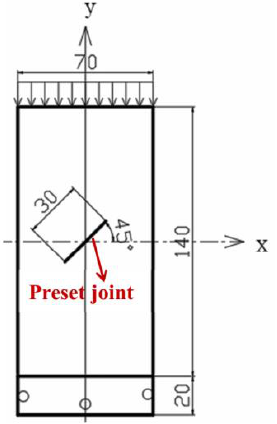
Figure 8. Rock model geometric parameters (mm). Table 2. Mechanical parameters of the rock models.